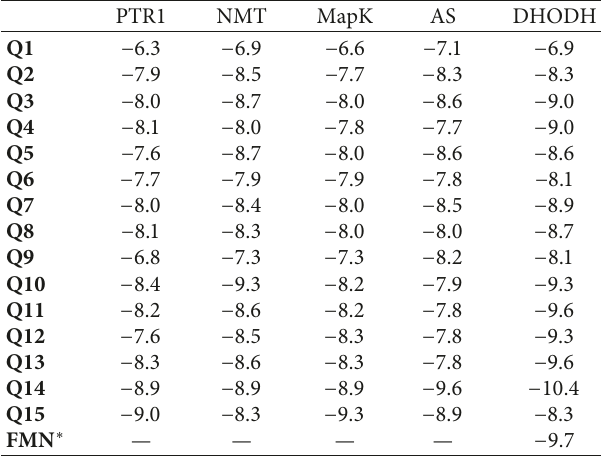
Table 2: Docking energies (kcal/mol) of the synthesized